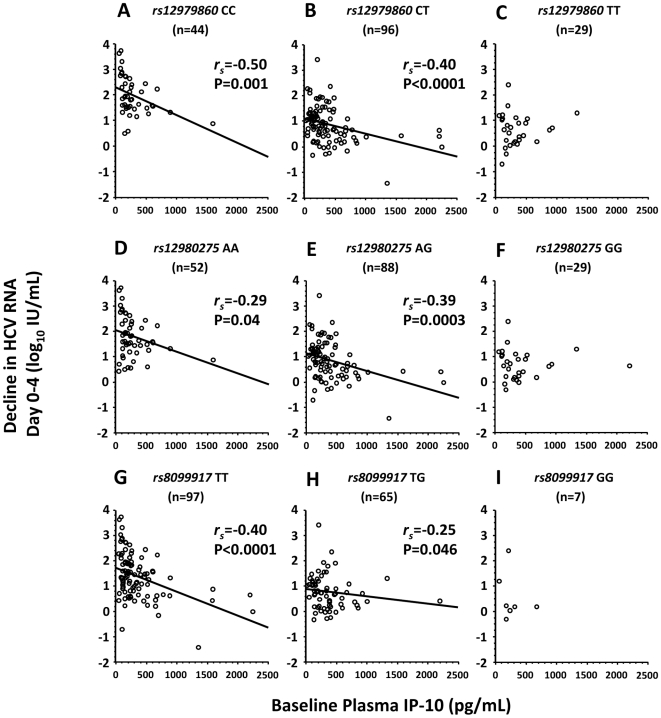
Correlation between IP-10 and first phase decline in IL28B variants among HCV genotype 1 patients.